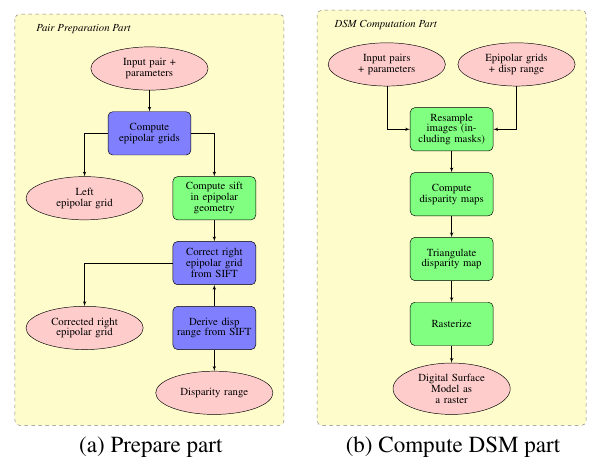
Figure 1. Workflow for the two steps of CARS. Green blocks are distributed and blue blocks are sequential CARS performs MultiView Stereo (MVS), meaning that mul- tiple views are grouped and processed by pairs by means of epipolar resampling and 1D dense matching (also called